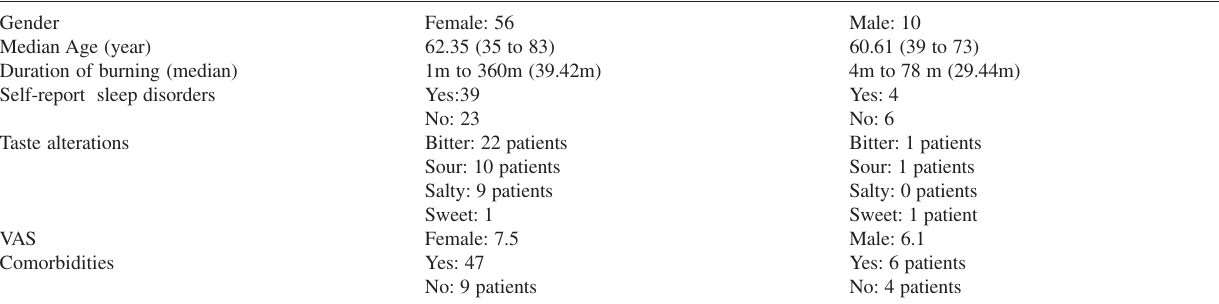
Table 1 - General characteristics of the sample (n=66) Gender Female: